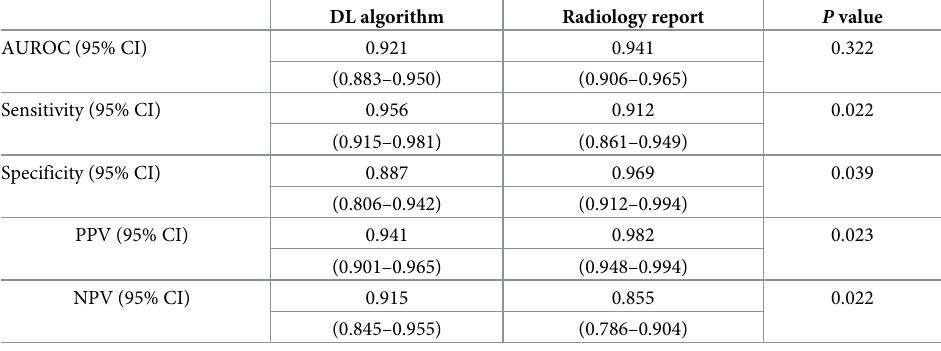
Table 2. Performance of deep learning algorithm for detection of COVID-19 with and without pneumonia on chest